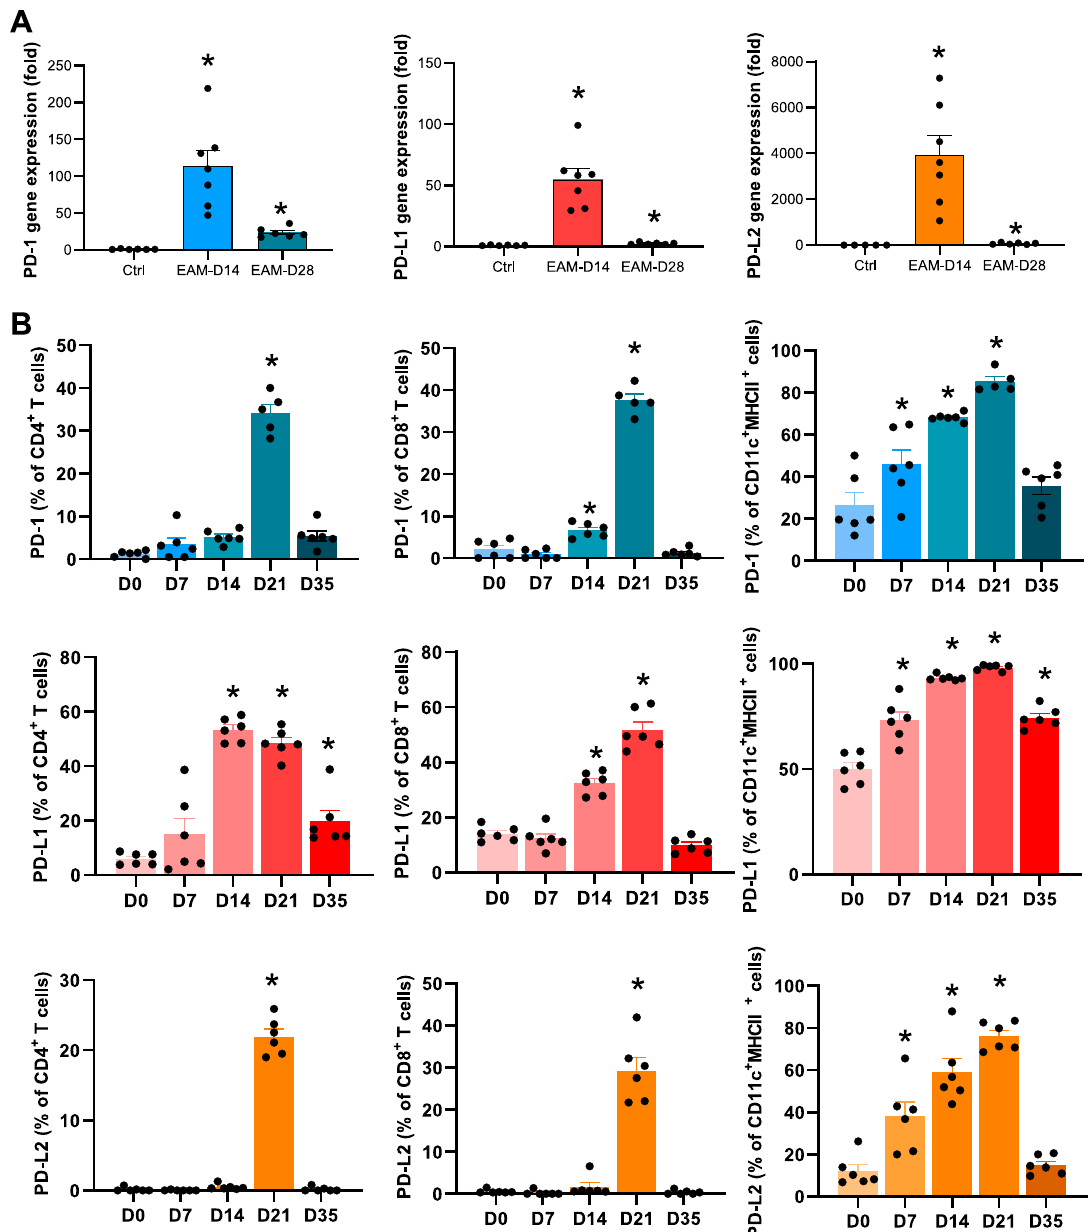
Figure 2. Expression levels of programmed cell death protein 1 (PD-1) and programmed cell death ligands (PD-Ls) in the experimental autoimmune myocarditis (EAM) hearts. ( A ) mRNA expression of PD-1, PD-L1, and PD-L2 in the hearts obtained from mice with EAM (days 14 and 28) and control mice (n = 6–7). ( B ) Flow cytometric analysis of the expression of PD-1, PD-L1, or PD-L2 on infiltrating CD4 + T cells, CD8 + T cells, and CD11c + MHC II + dendritic cells in the hearts obtained from mice with EAM on days 0, 7, 14, 21, and 35 after first immunization with cardiac myosin peptide (n = 6 at each time point). Results are presented as the mean ± standard error of the mean. * P < 0.05 vs. day 0.